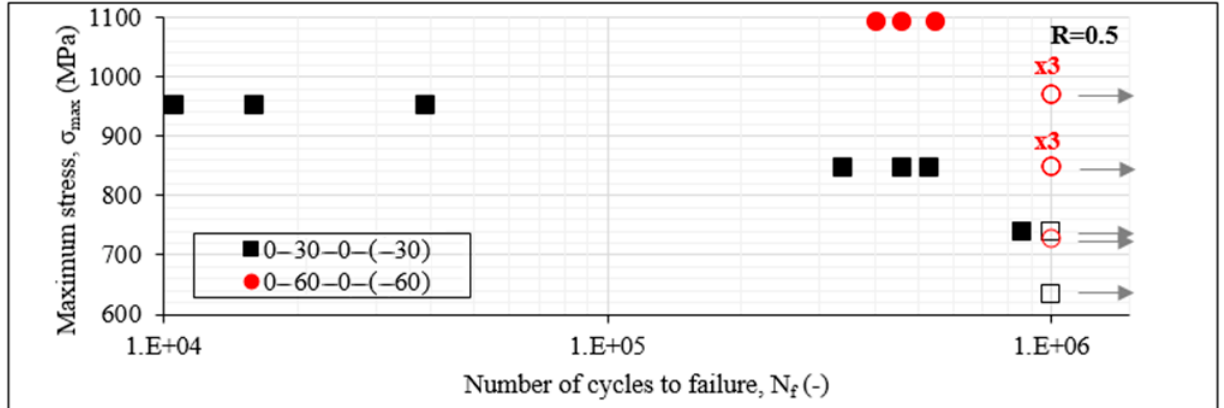
Figure 7. S-N f data of [0°/30°/0°/ − 30°] s and [0°/60°/0°/ − 60°] s laminates for R = 0.5.